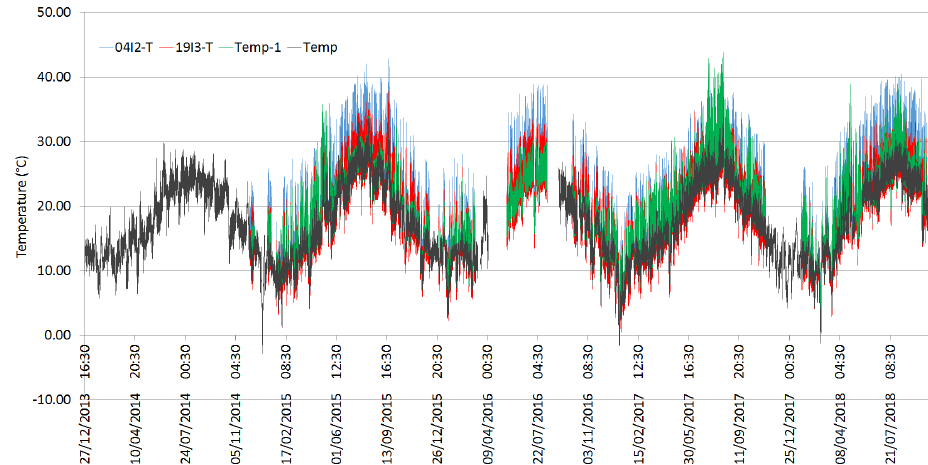
Figure 10. Temperature time series showing daily, seasonal and annual variation patterns. Long-term trends, based on about 5 consecutive years of data, show annual cyclicity. Air temperature and near-rock-surface air temperature are fully synchronous; peaks in near-rock-surface air temperatures (19I3-T, 04I2-T and Temp-1) are sometimes higher than those of air temperature (Temp). Data are incomplete in some months.